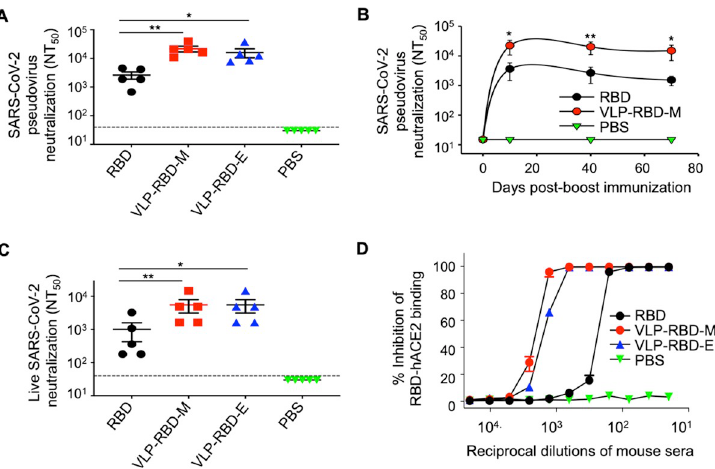
Fig 3. Antibody responses induced by VLP-RBD vaccine potently neutralize SARS-CoV-2 infection in vitro . Mouse sera from day 10 post-2 nd immunization were examined for neutralizing antibodies against cell entry of pseudotyped SARS-CoV-2 (A) and cell infection of authentic SARS-CoV-2 (C). Mouse sera collected on later dates were also examined for neutralizing antibodies against cell entry of pseudotyped SARS-CoV-2 (B). For pseudovirus entry assay, retroviruses pseudotyped with SARS-CoV-2 spike were used to enter human cells in the presence of serially diluted mouse sera, and efficiency of pseudovirus entry was characterized as luciferase signal accompanying entry. For live virus assay, live SARS-CoV-2 was used to infect human cells in the presence of serially diluted mouse sera, and efficiency of live virus infection was characterized as cytopathic effect (CPE) of infected target cells. Neutralizing activity of serum antibodies against pseudoviruses or live SARS-CoV-2 was expressed as NT 50 (neutralization titer that inhibits pseudovirus entry or live virus infection by 50%). The dotted lines indicate the detection limit for each experiment (defined as the lowest serum dilution). (D) Mouse sera from day 10 post-2 nd immunization were tested for blocking the interaction between SARS-CoV-2 RBD and human ACE2 receptor using flow cytometry. Recombinant RBD was incubated with cells expressing ACE2 in the presence of mouse sera, and efficiency of binding was characterized by flow cytometry signal (i.e., fluorescence intensity of cells). Inhibition (%) was derived from flow cytometry signal in the presence or absence of mouse sera. The data are presented as mean ± SEM (n = 5 for mice in each group). A Student’s two-tailed t -test was performed to analyze the statistical differences among the groups. ��� p < 0.001; �� p < 0.01; � p < 0.05. Experiments were repeated twice with similar